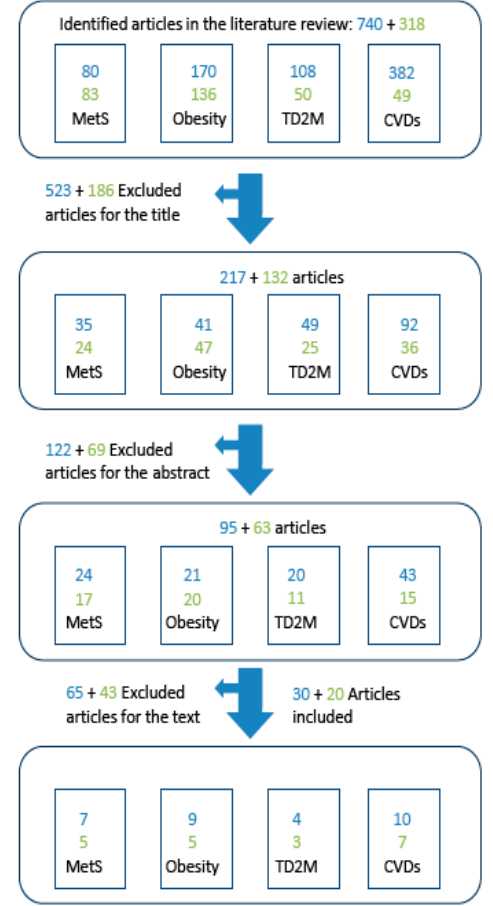
Figure 2. Selection process for studies included in the systematic review. The numbers in blue refer to the articles included and excluded by García-Fernández et al. [6]. The numbers in green refer to the additional articles included in and excluded from this updated review.